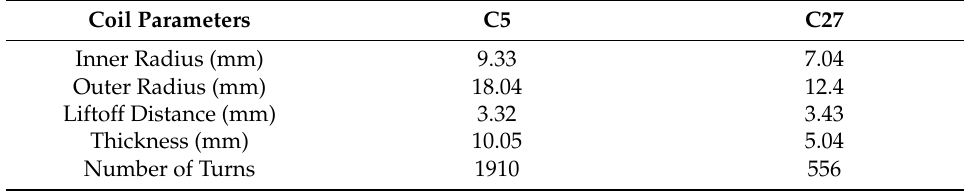
Table 1. Information on the coils with finite cross sections.